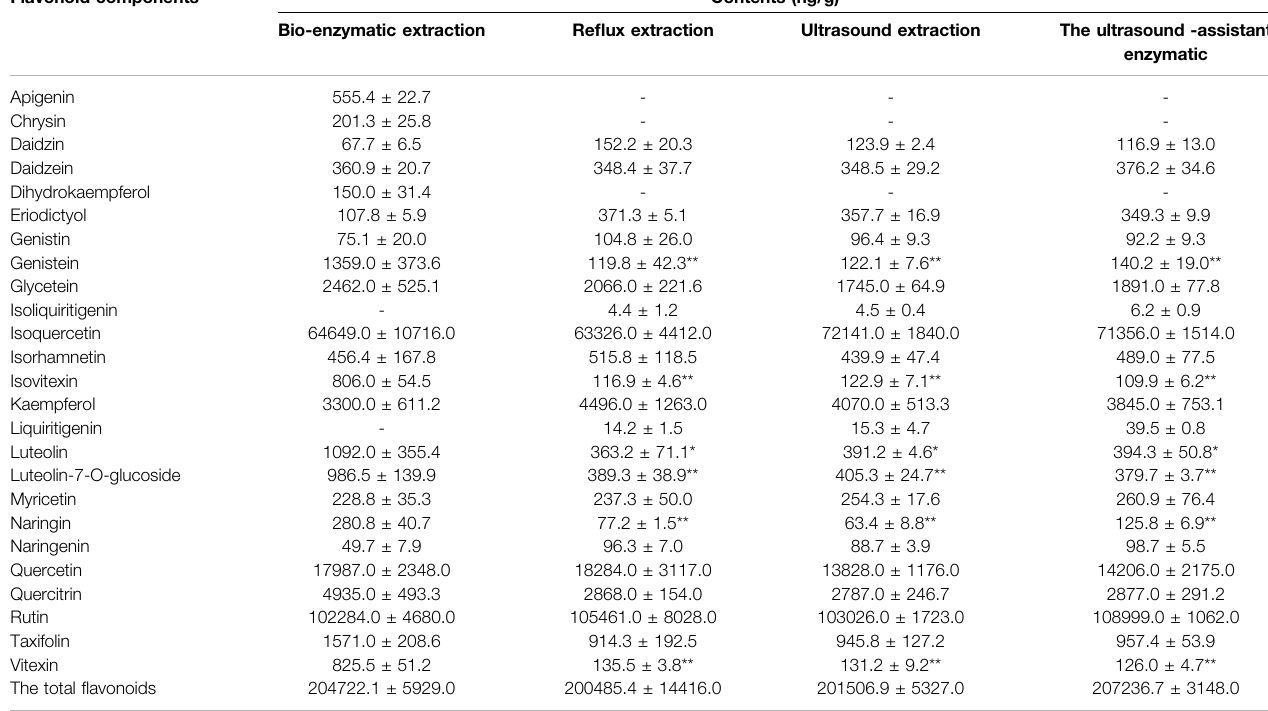
TABLE 4 | Determination of fl avonoids components ’ contents ( n =